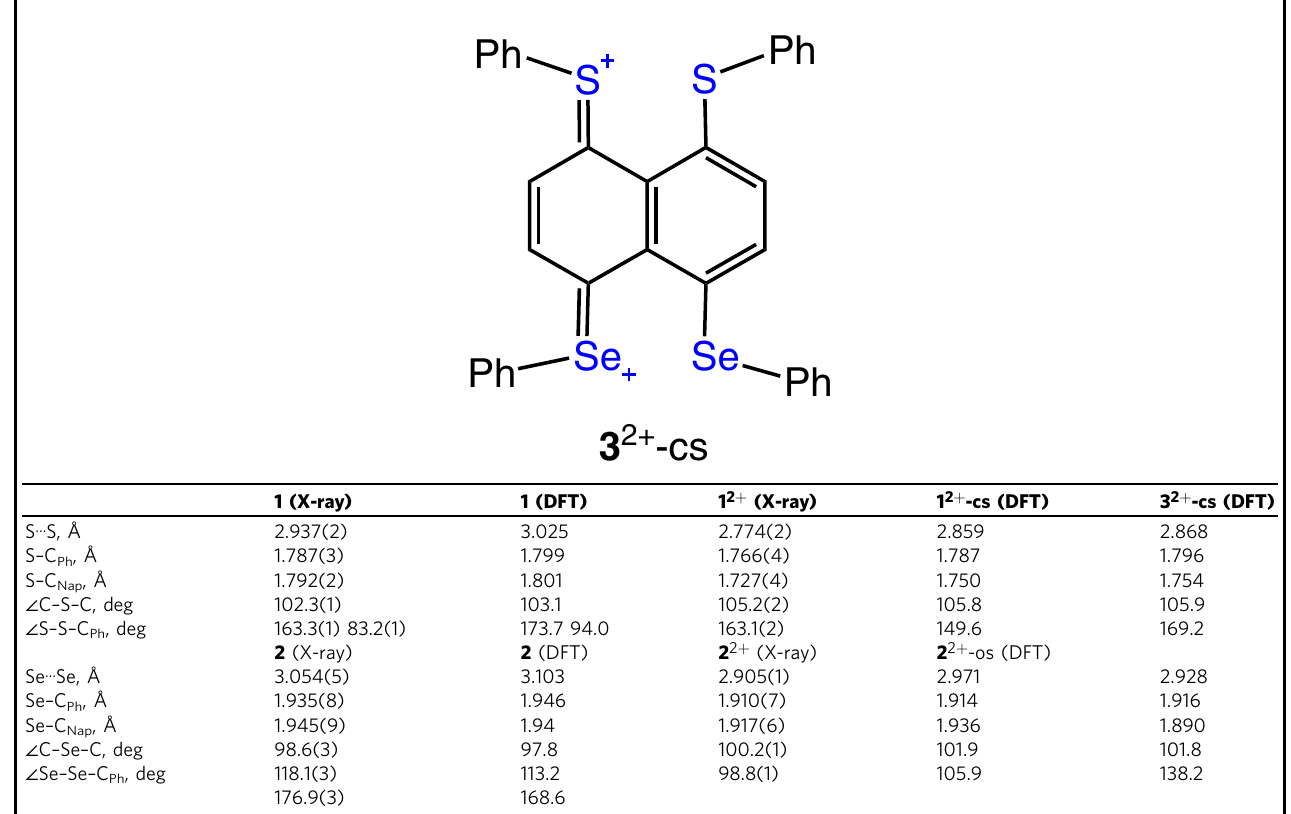
Table 1 Comparison of structural parameters (average) of neutral and